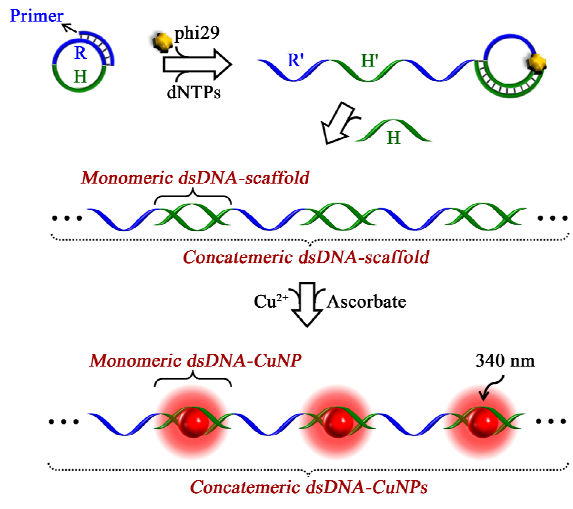
Figure 3. Schematic showing the principle of the RCR-mediated concatemeric dsDNA-CuNPs strategy. Reprinted with permission from [29]. Copyright 2014 American Chemical